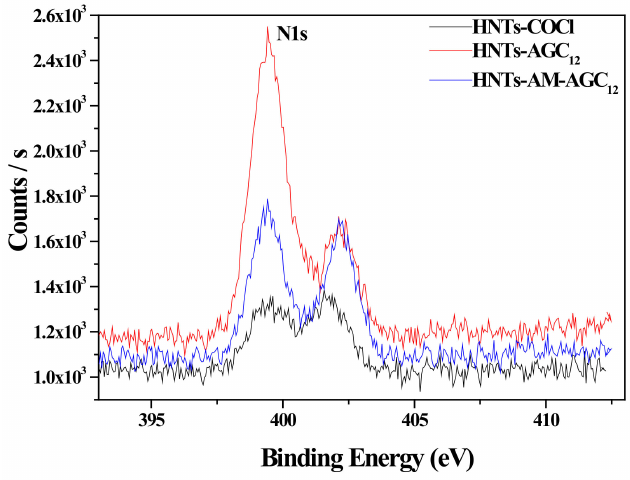
Figure 3. XPS spectra of HNTs before and after modification.